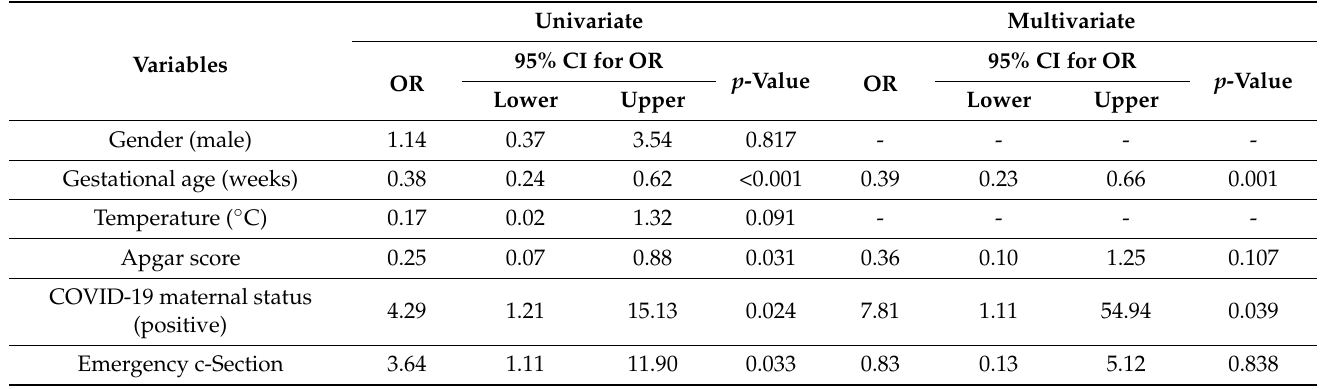
Table 5. Univariate and multivariate regression analysis for predictors of NICU